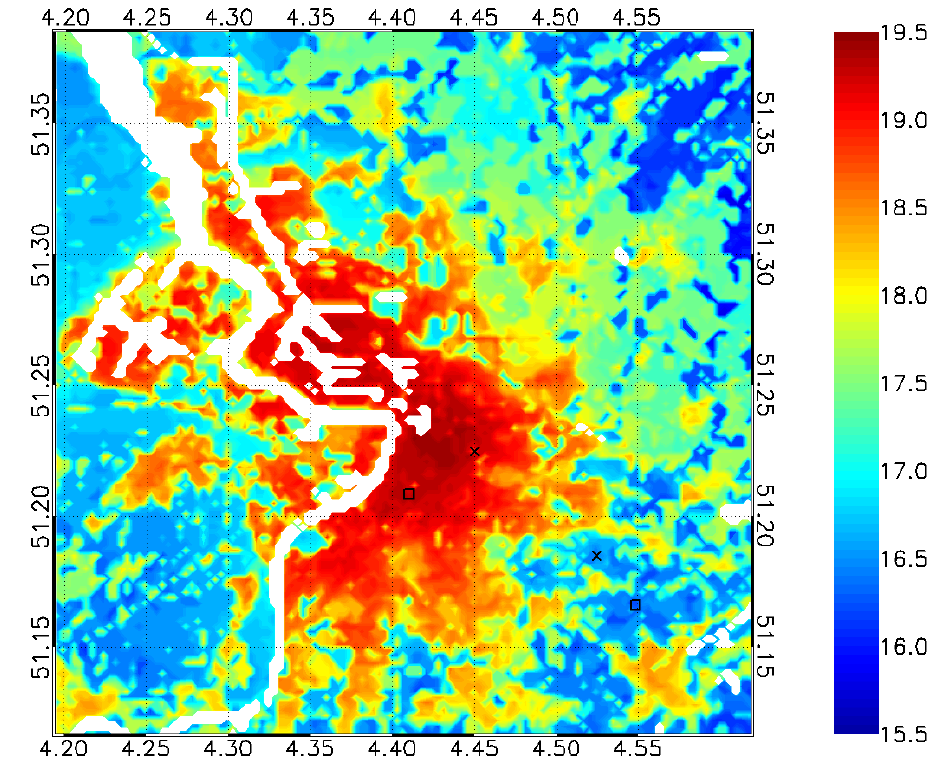
Figure 2. Temperature indicator for Antwerp for the period 1986–2005, based on ERA-Interim-driven UrbClim simulations. The urban and rural measurement locations from Figure 1 are denoted with a black square. The spatial P90 and P10 locations are denoted with a black cross. Grid cells over water are omitted from the